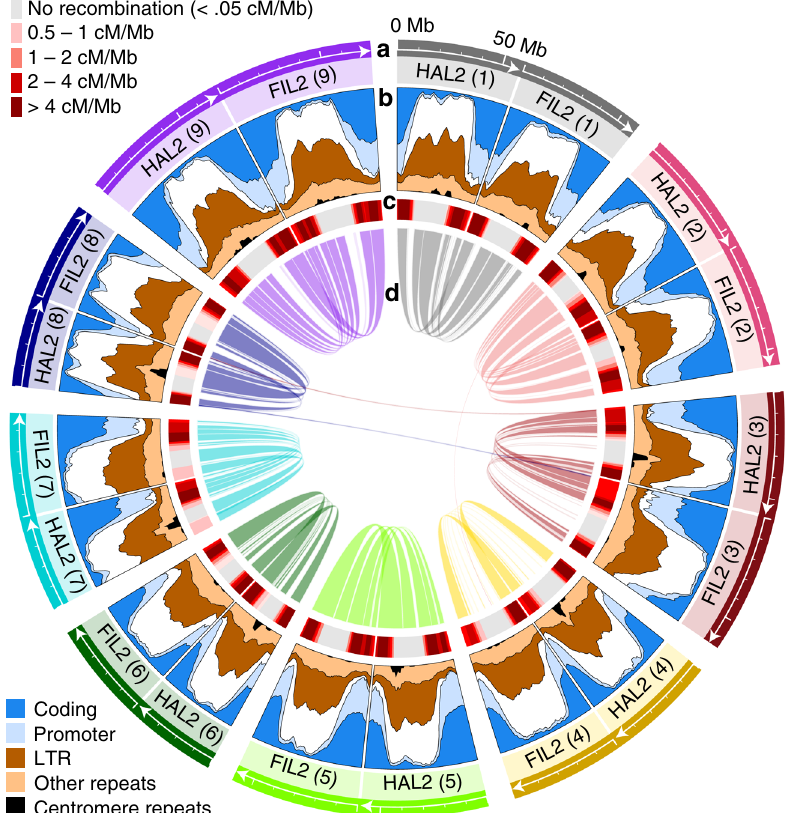
Fig. 2 Synteny and structure of the P. hallii genome. The P. hallii genomes are characterized by highly genic chromosome arms and non-recombinant pericentromeric regions. The physical size and orientation of each chromosome (minor ticks at 10 Mb intervals) are plotted along the outer-most track ( a ). Gene models and repetitive sequences were annotated for both assemblies - the proportional representation (in 5 Mb overlapping windows) of fi ve annotation categories, and unannotated intergenic sequence (white), are plotted in the second track ( b ). A heatmap of recombination rate (cM/Mb) is shown in the third track ( c ), where the darkest red represents >4% chance of a crossover event per F 2 individual per Mb. The interior links ( d ) connect 72 syntenic blocks, which cover 369.2 Mb (75.8%) of the total HAL2 assembly and 254 Mb (84.5%) of the chromosome arms. Source data are provided